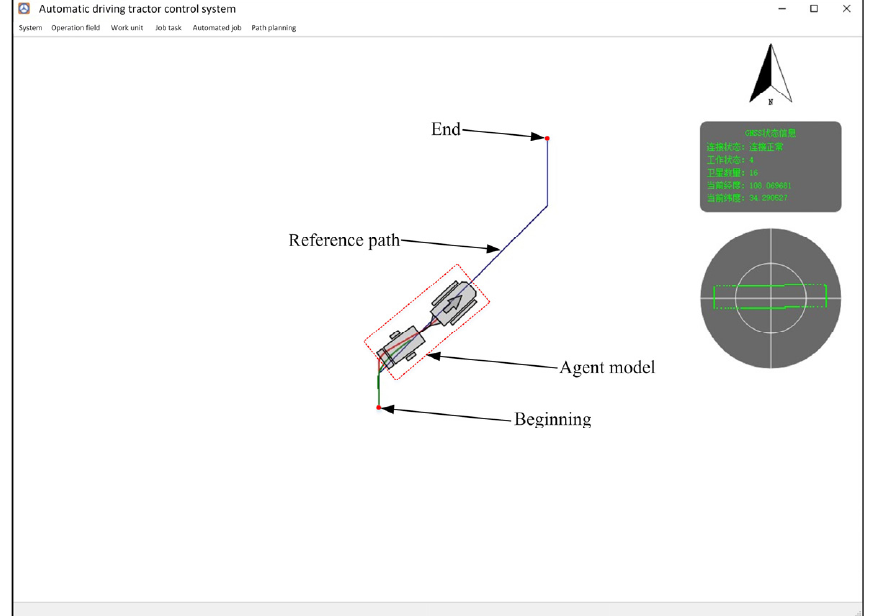
Figure 9. The agent simulation environment.